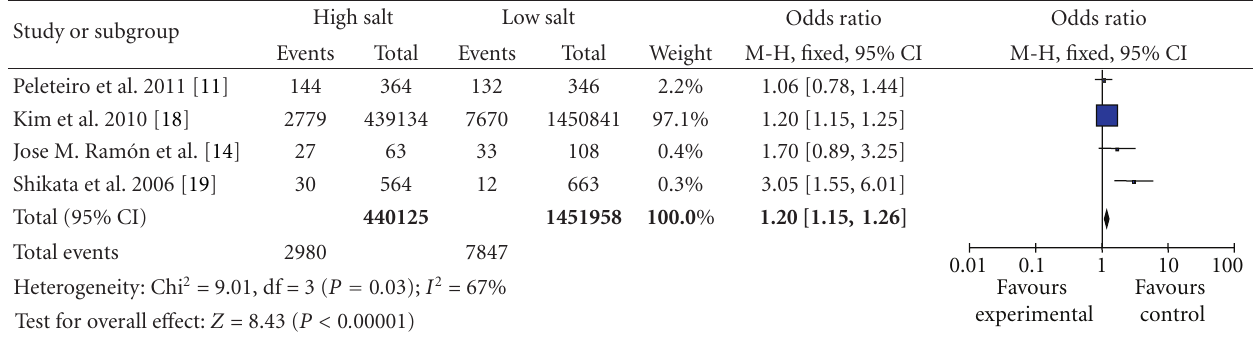
Table 7: High versus low categories of salt and gastric cancer through salt.